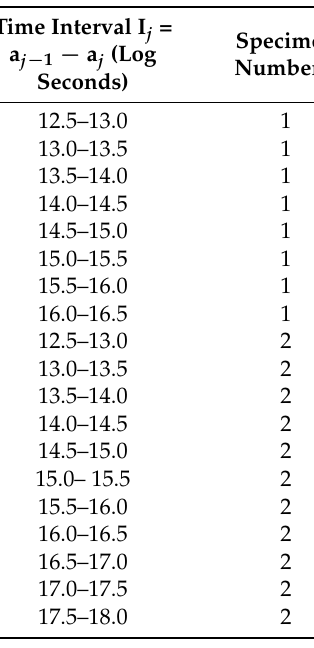
Table 1. Illustration of the creation of a specimens-specimen